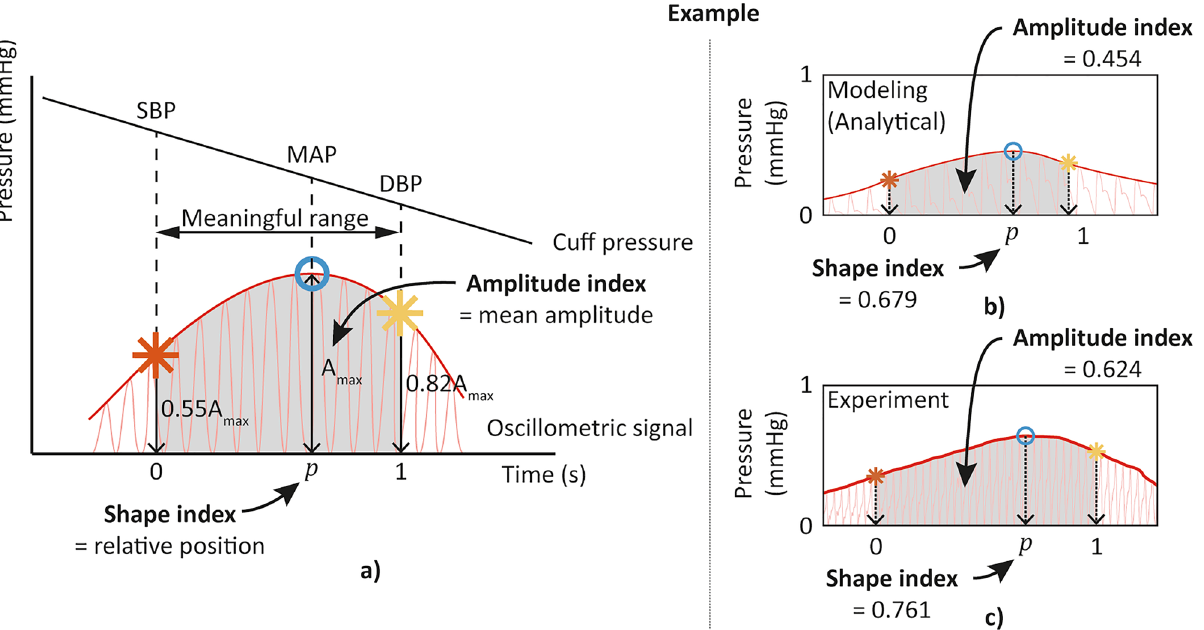
Figure 5. Oscillometric signal evaluation indices with meaningful range indicated. ( a ) Setting of the meaningful range of the oscillometric signal based on the maximum amplitude algorithm, and definition of an amplitude index and a shape index. Example calculation of two indices with the oscillometric signal obtained through ( b ) the modeling, and ( c ) the